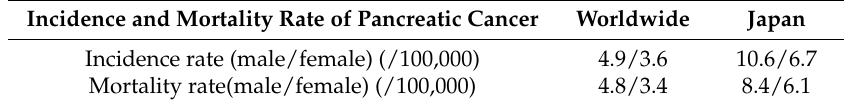
Table 1. Comparison of incidence and mortality rate of pancreatic cancer in the world and in Japan. Incidence and Mortality Rate of Pancreatic Cancer Worldwide